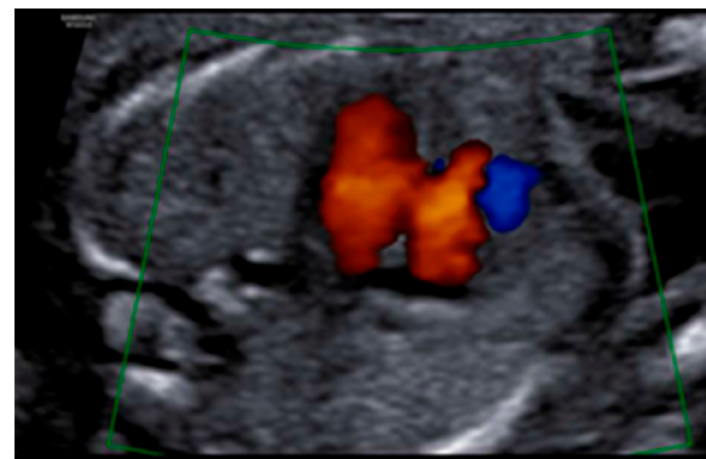
Figure 7. Normal four-chamber Yagel slice.